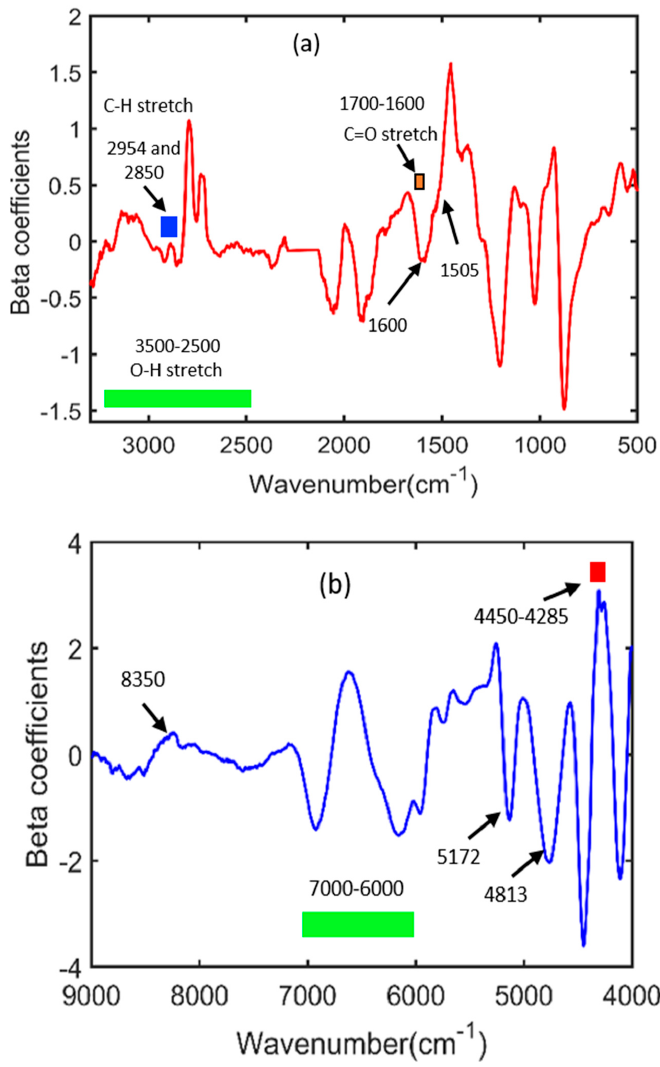
Figure 14. Beta coefficient plots developed through the PLSR model: ( a ) FT − IR spectroscopy and ( b ) FT − NIR spectroscopy.